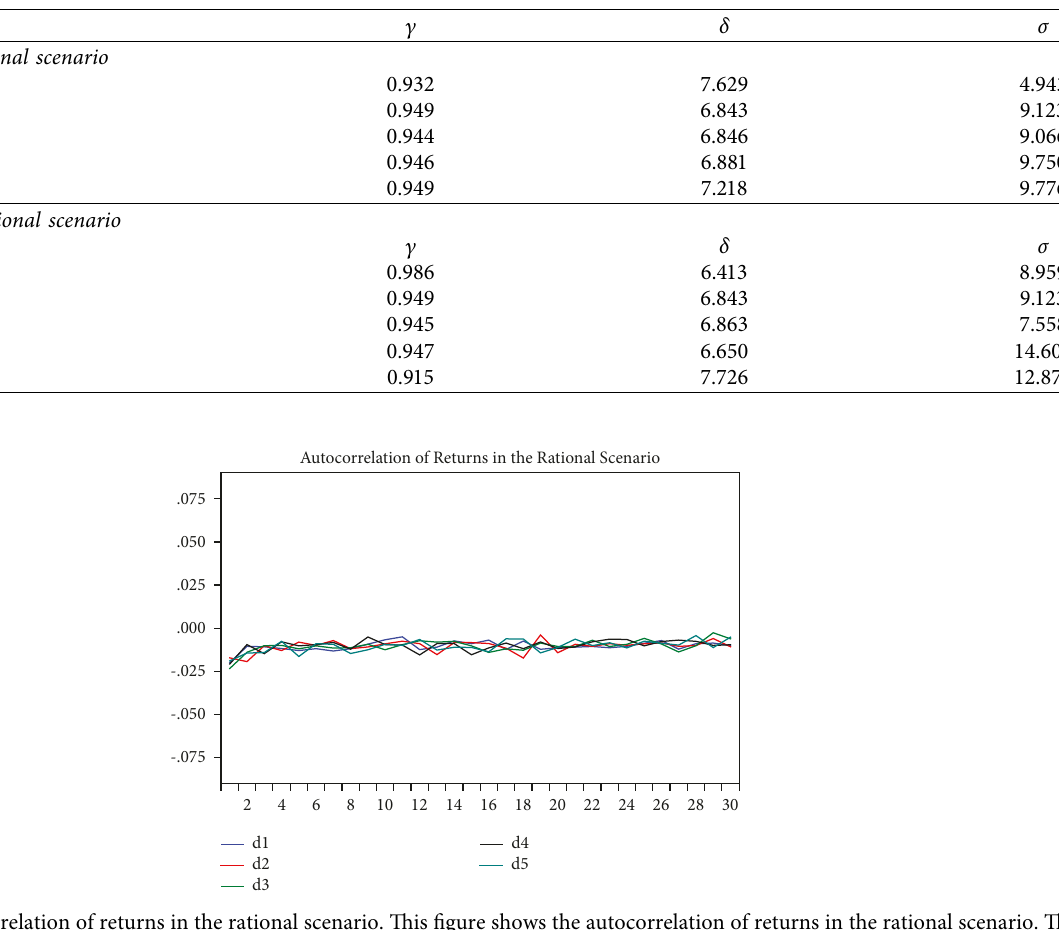
Table 7: Calibrated parameters of the model. Note: In this table, the calibrated parameters of the model are presented, including c and δ in price determination, as well as σ in modeling the fundamental price. d denotes the magnitude of the behavioral hesitation and decision rigidity of the anxious agent.